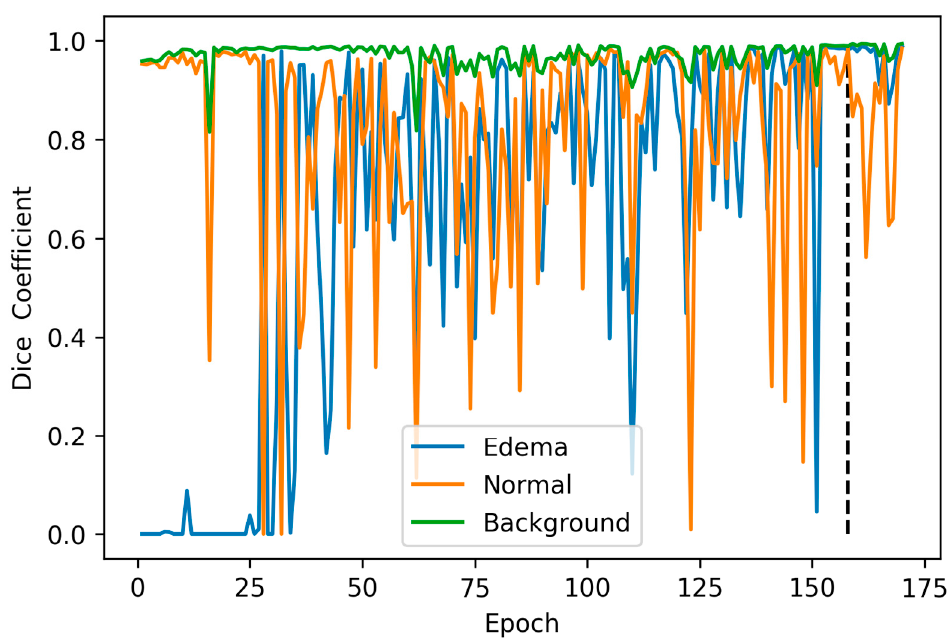
Figure 4. Dice coefficients of the test set of Epi Edema Detector and Stroma Edema Detector during training. The dashed vertical line indicates the end of Epi Edema Detector’s training and the beginning of Stroma Edema Detector’s training.